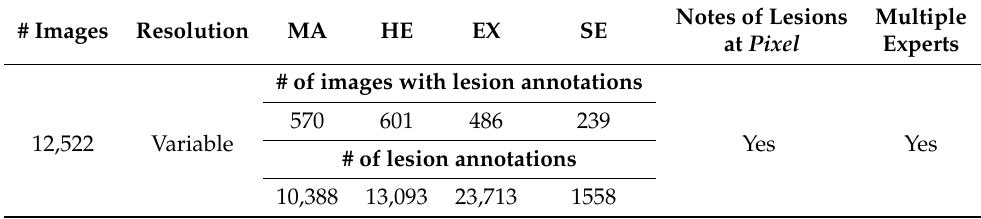
Table 2. Number of annotated images for Microaneurysms, Hemorrhages, Hard Exudates, and Soft Exudates and the total amount of annotations by lesion type in the Dataset for Diabetic Retinopathy (DDR) before the data augmentation